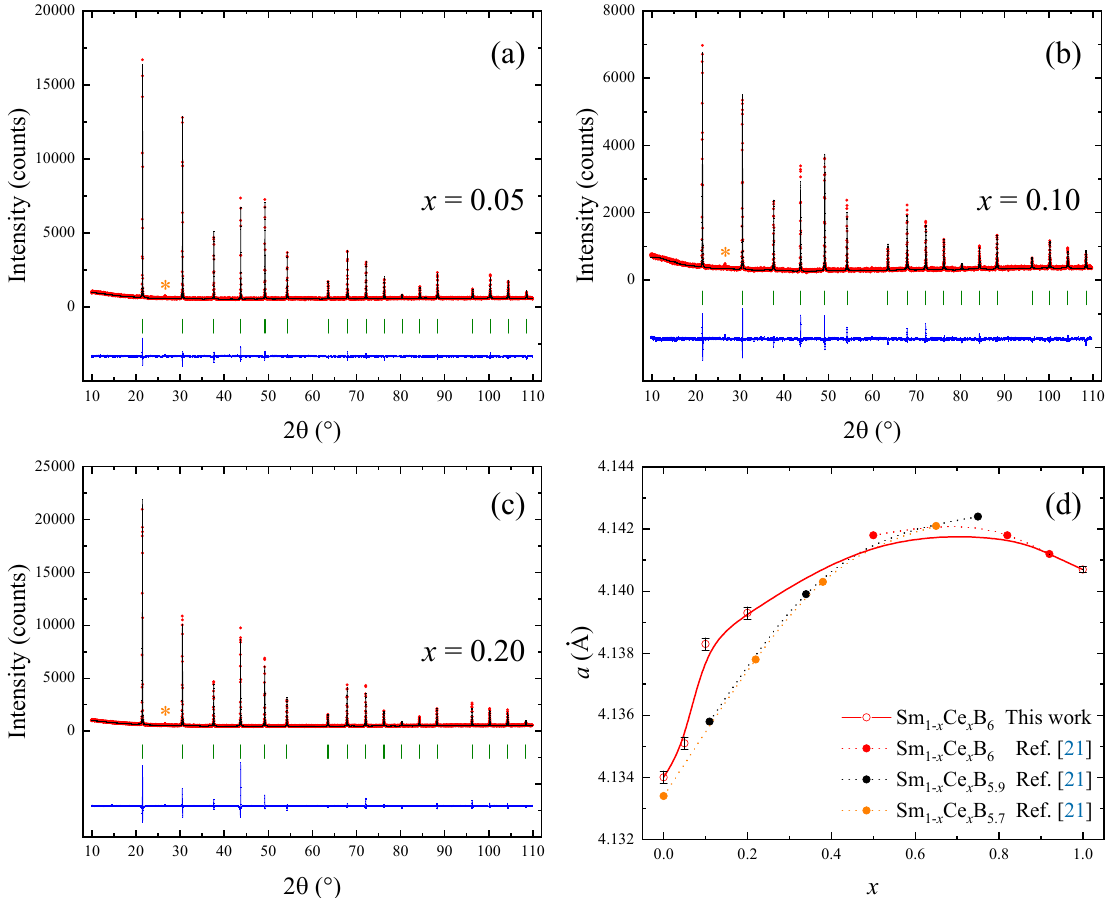
Figure 2. Powder X-ray diffraction patterns of Sm 1 − x Ce x B 6 with ( a ) x = 0.05, ( b ) x = 0.10 and ( c ) x = 0.20) for samples taken from the crystal boules. The experimental profile (red closed circles) and a full profile matching refinement (black solid line) made using the Pm 3 m cubic structure are shown, with the difference given by the blue solid line. The orange coloured symbols * indicate the impurity peaks belonging to SmBO 3 impurity phases. ( d ) Evolution of the lattice parameter, a , as a function of the concentration, x , of the Ce-substituent for Sm 1 − x Ce x B 6 . The experimental values obtained in the present work (red open circles) are also given in Table 1. The previously reported values (red, black and orange closed circles) of the crystallographic parameters for the Sm 1 − x Ce x B 6 − y series [21] are given for